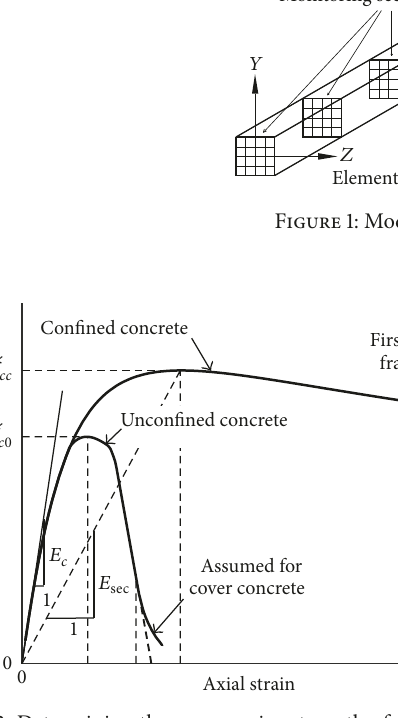
Figure 2: Determining the compressive strength of confined con- crete in accordance with Mander